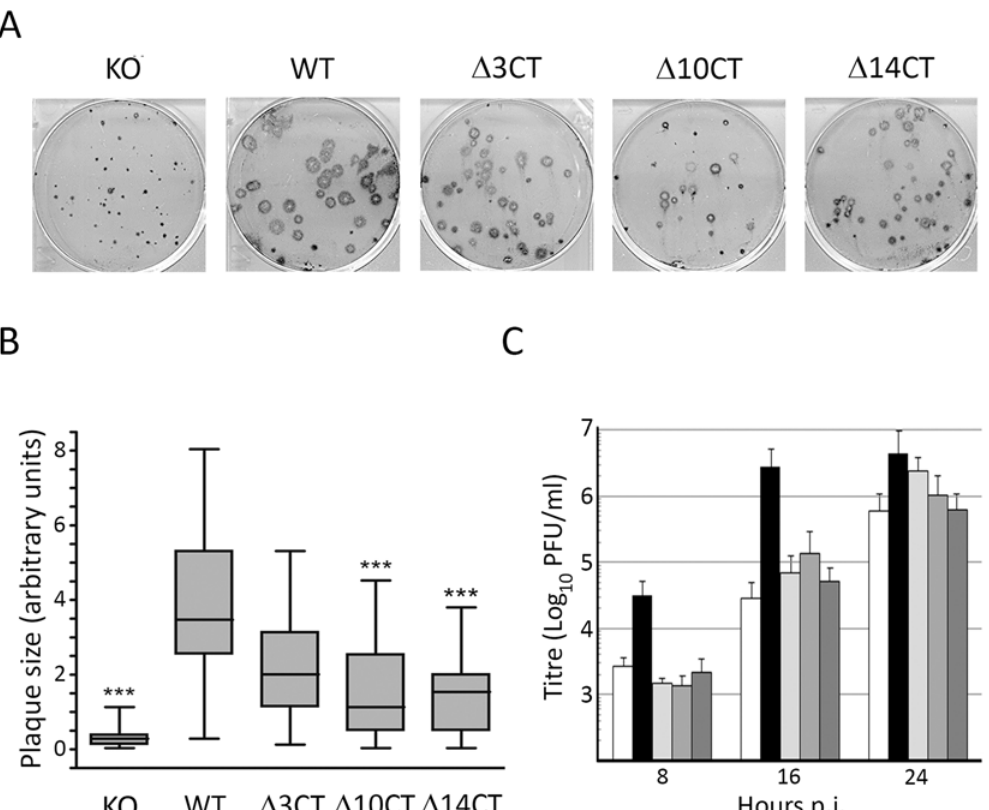
Fig 7. VP5 C-terminal ablation affects the IBDV plaque size phenotype. A. Plaque assays. QM7 cell monolayers were infected with the VP5 knockout mutant (KO) virus, the wild type (WT) virus and mutant IBDV viruses lacking 3 ( Δ 3CT), 10 ( Δ 10CT), and 14 ( Δ 14CT) VP5 C-terminal residues, respectively. After infection, monolayers were covered with semisolid medium. After three days, the medium was removed and virus-induced plaques were detected by immunostaining using serum specifically recognizing the VP2 IBDV capsid polypeptide. B. Statistical analysis. The statistical analysis was carried on images from immnunostained monolayers using the GraphPad Prism software 4.0. A Kruskal-Wallis test was performed followed by Dunn ’ s multiple comparison tests between lysis plaque areas detected in monolayers infected with the different mutant viruses and those generated by the wild type virus. Presented data correspond to three independent experiments totalizing 750 plaques for each virus. Significant differences (p < 0.001) between KO, Δ 10CT, Δ 14CT and WT viruses are indicated with asterisks ( *** ). C. Extracellular virus yields. QM7 cells were infected with the VP5 knockout mutant (white columns), wild type (black) and mutants viruses VP5 Δ 3CT (light grey), VP5 Δ 10CT (medium grey), and Δ 14CT (dark grey), at an MOI of 3 PFU/cell. At 8, 16 and 24 h p.i. cultures were harvested and subjected to centrifugation at 15,000xg for 15 min to eliminate cells and large debris. The corresponding supernatants were used to determine extracellular virus titres. Presented data correspond to three independent